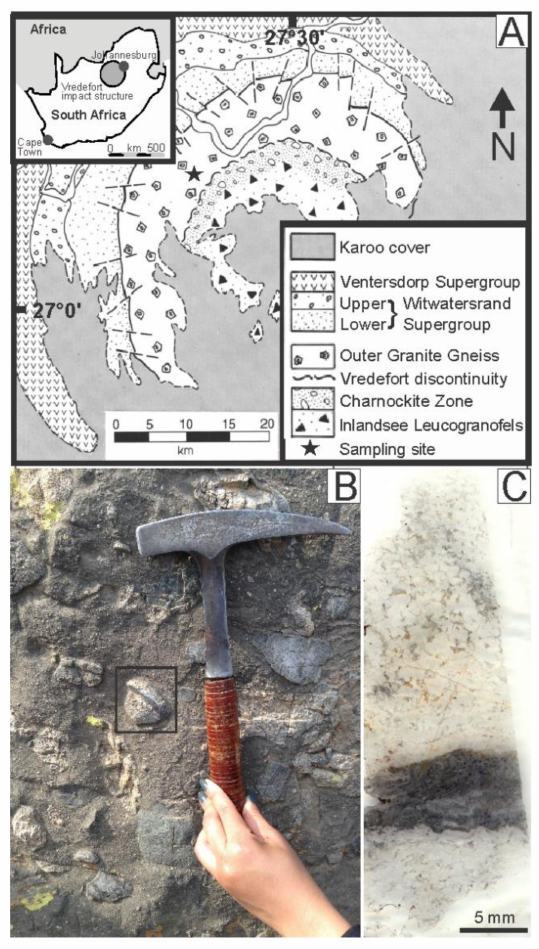
Figure1. ( A )SimplifiedgeologicalmapoftheVredefortimpactstructure, after[25].( B )Fieldphotograph of the sampled outcrop, after [20]. The granophyre matrix (brown) contains multiple lithic clasts (light-grey). The rectangle shows the sampled clast. ( C ) Thin section of the sampled clast with the pseudotachylite vein (dark grey) and its host meta-granite (light